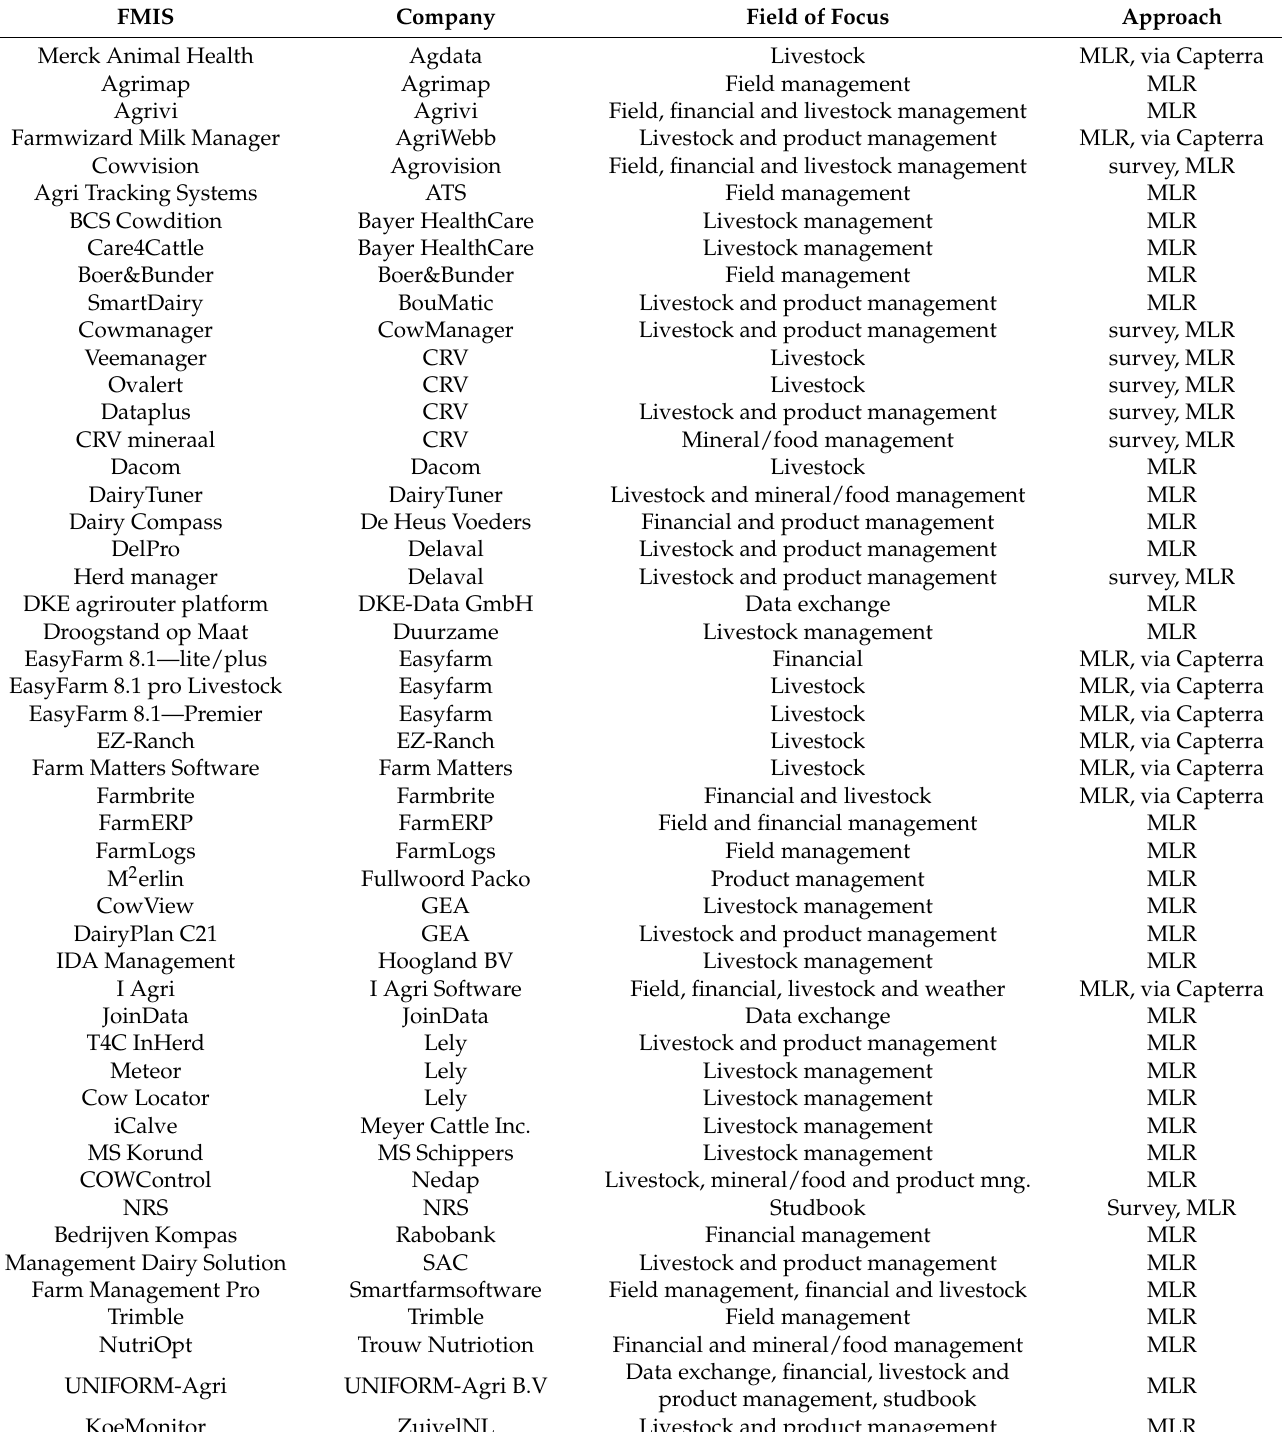
Table 3. An overview of the retrieved FMISs in this